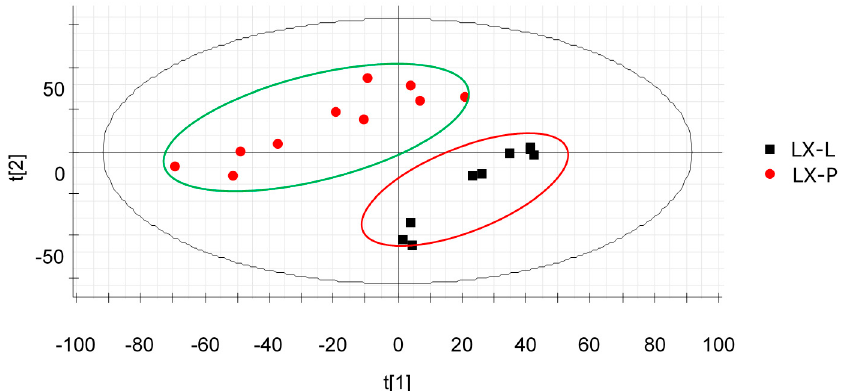
Figure 2. The principal component analysis (PCA) of LX-L and LX-P. LX-P: Natural air dried